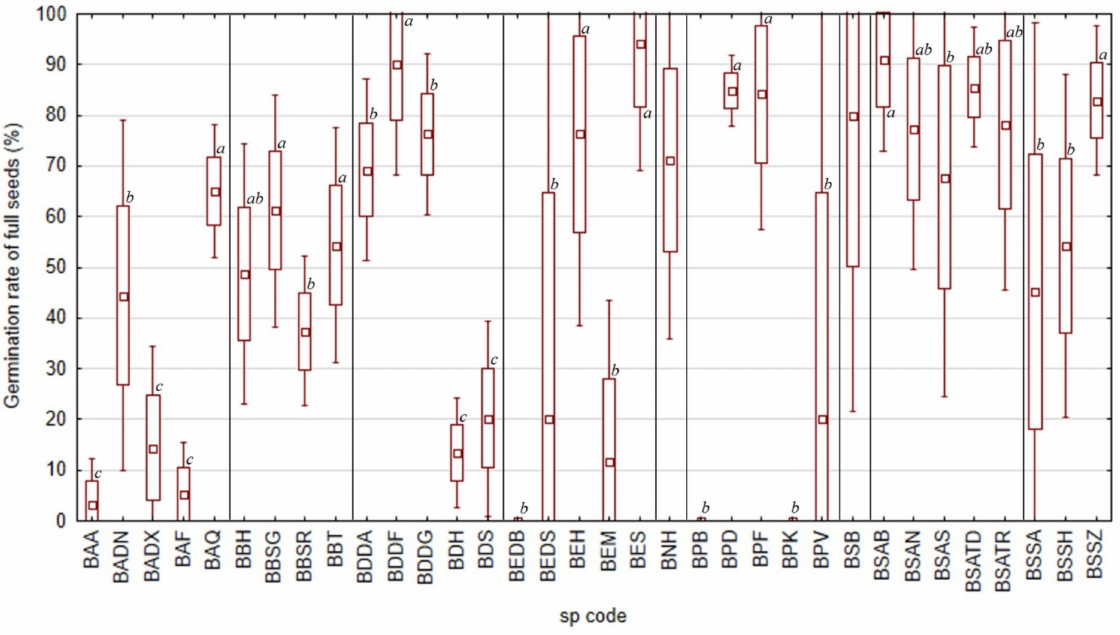
Figure 4. Seed germination rate of full seeds of all nine taxa of Boswellia from Socotra Island from different localities in 2021 (a, b, c—Indexes denoting localities with significantly separate germination rates within individual taxon, the same index associates the seed without statistically significant difference in germination rate of full